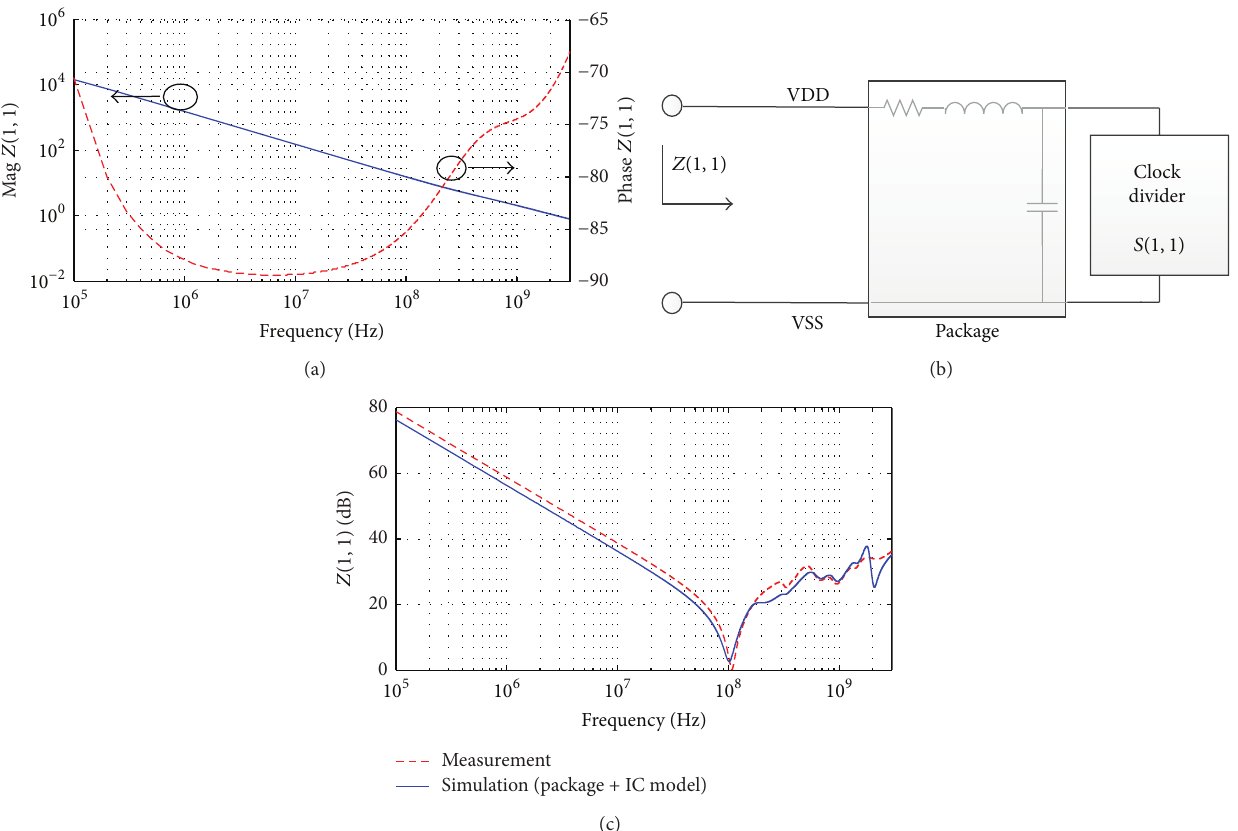
Figure 7: Chip model validation. (a) VDD/VSS port impedance of IC. (b) Package and IC simulation setup. (c) Chip VDD/VSS port impedance 𝑍(1, 1) comparison.